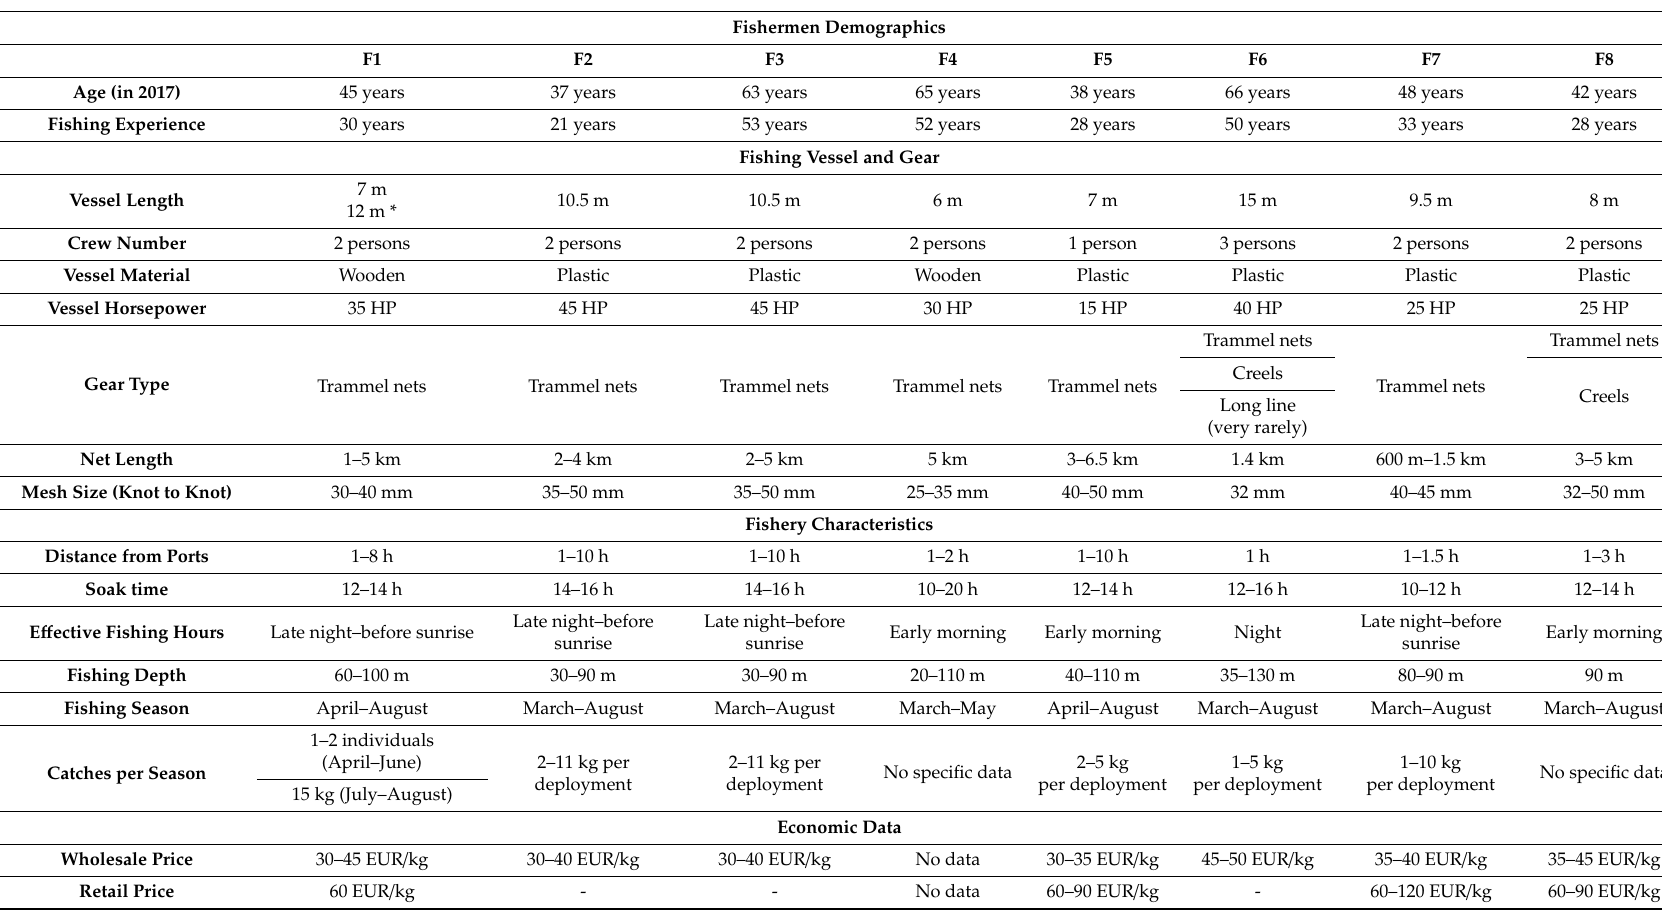
Table 2. Characteristics of the spiny lobster fishery along the Chalkidiki Peninsula and its status based on interviews and questionnaires. Fishermen